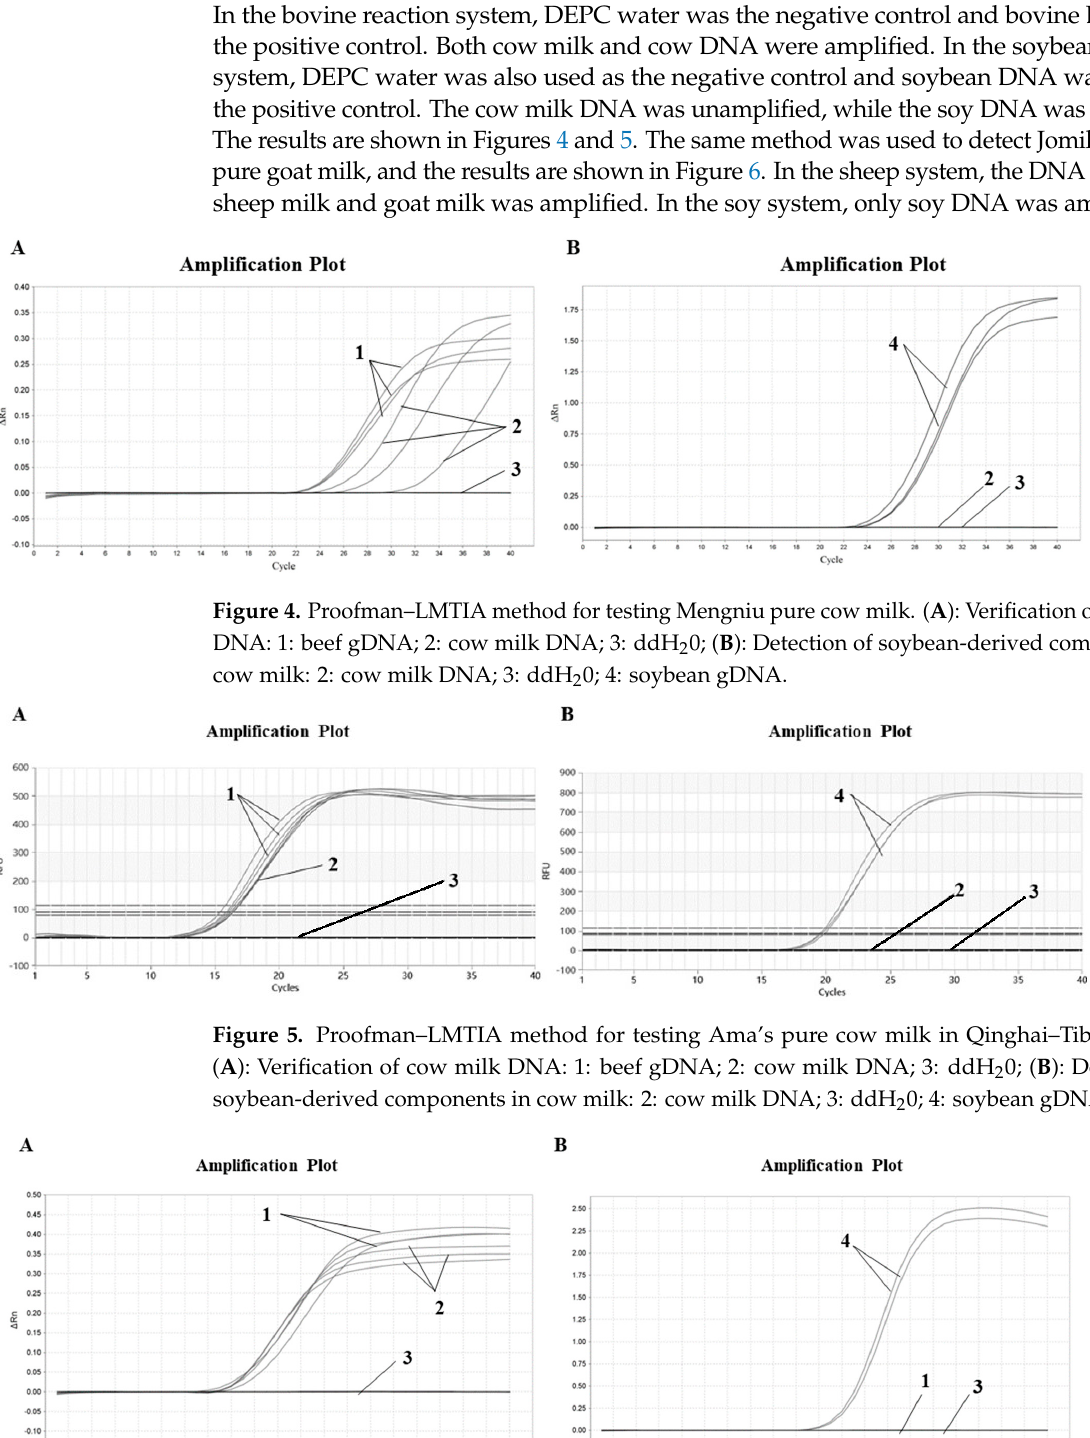
Figure 3. Proofman–LMTIA response sensitivity test for ITS gene in soybean. Varying amounts of gDNAs of the following: 1: soybean 100 pg/ μ L; 2: soybean 10 pg/ μ L; 3: soybean 1 pg/ μ L; 4: ddH 2 O.